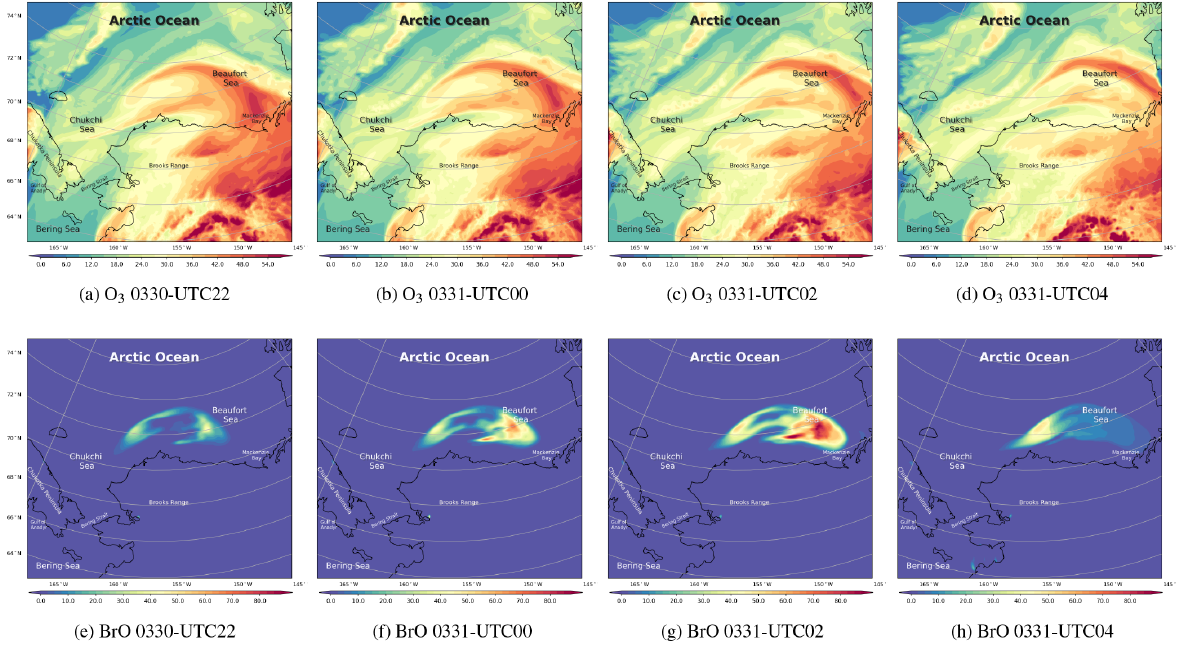
Figure 8. The spatial distribution of the surface ozone (ppb) and BrO (ppt) simulated by CMAQ from 30 to 31 March.